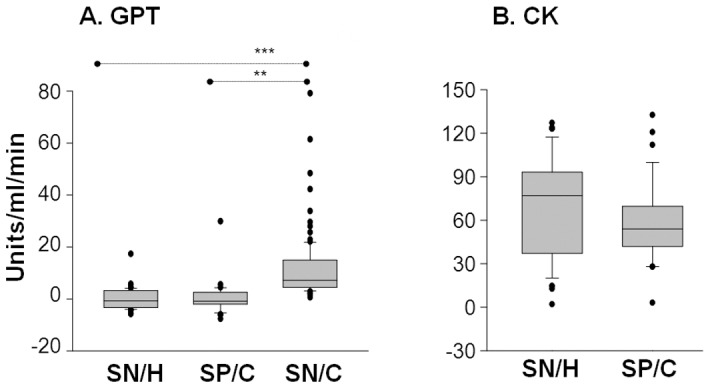
Metabolic markers of tissue injury were not significantly altered in chagasic subjects.Shown are plasma levels of activities of the glutamate pyruvate transaminase (A) and creatine kinase (B), determined by spectrophotometry.